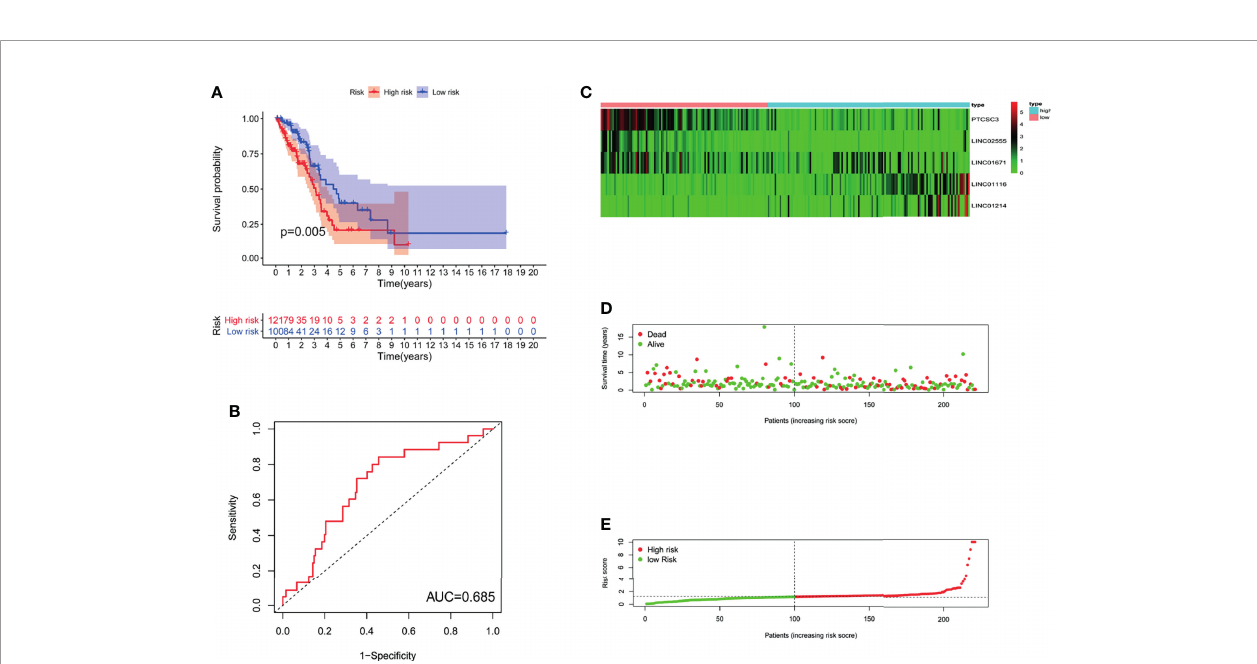
FIGURE 3 | The GILncSig associated with OS of LUAD in testing set. (A) Log-rank test was performed to draw a Kaplan Meier survival curve to predict the overall survival of GILncSig in low-risk or high-risk patients in testing set. (B) ROC analysis of the GILncSig in testing set. ( C ) Heat map of 5 genomic instability-derived lncRNA expression patterns in testing set. ( D ) The survival status of LUAD patients. The dotted line represents the median of the risk score; the number of deaths in the right part of the patient is greater than the left part, indicating that as the risk score increases, the risk of death increases. (E) Risk score distribution of LUAD patients.